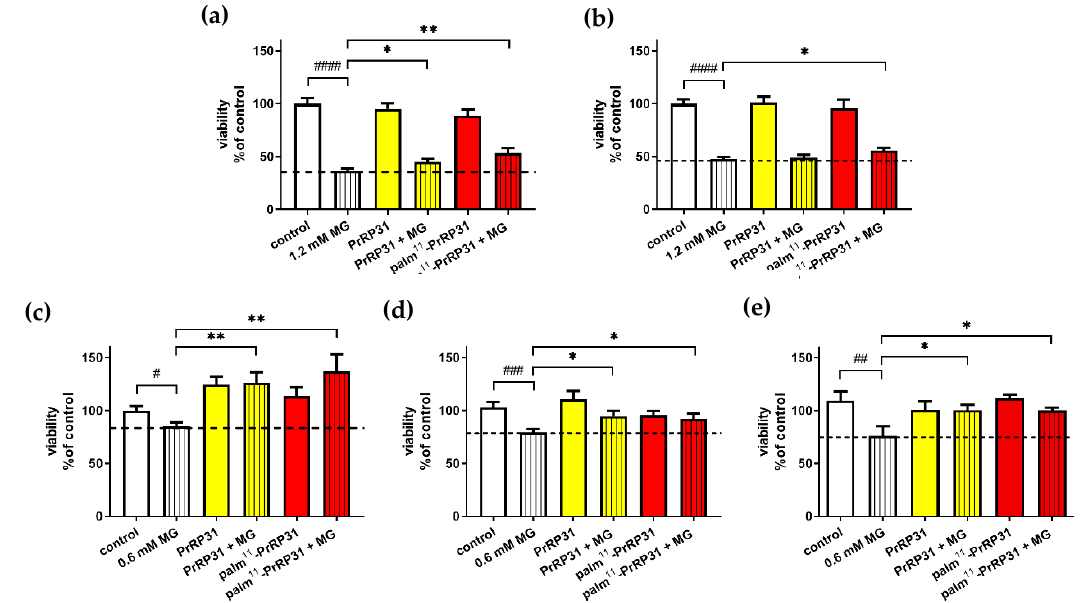
Figure 5. PrRP31 and its analog increased cell viability during the MG-induced stress. Pre-treatment for 4 h with PrRP31 and palm 11 -PrRP31 at a concentration of: ( a ) 1 × 10 − 5 M; or ( b ) 1 × 10 − 7 M, followed by exposure to 1.2 mM MG for 16 h in SH-SY5Y cells. Pre-treatment for 4 h with PrRP31 and palm 11 -PrRP31 at a concentration of: ( c ) 1 × 10 − 5 M; ( d ) 1 × 10 − 7 M in SH-SY5Y cells; or ( e ) 1 × 10 − 5 M in rat primary neuronal culture, followed by exposure to 0.6 mM MG for 16 h in SH-SY5Y cells. MG toxicity was measured with MTT assay. Data are presented as the means ± SEM as a percentage of control cells treated with vehicle analyzed by a Student’s t -test vs. 0.6 mM MG # p < 0.5, ## p < 0.01, ### p < 0.001, #### p < 0.0001 ( n = 3, each sample in octuplicates). Control vs. 0.6 mM MG analyzed by a Student´s t -test, * p < 0.5, ** p < 0.01.